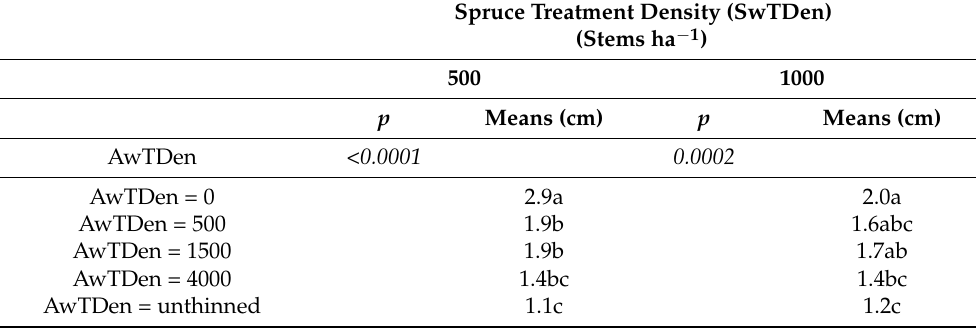
Table 6. Effects of treatments on maximum branch diameter in the branch whorl closest to 1 m of dominant spruce. Analysis for treatment effects was based on a factorial design with three levels for aspen density and two levels for spruce density—since the interaction term was significant, results were analyzed separately for each of the two spruce densities. For aspen treatment density (AwTDen), means followed by different letters (within each spruce density, SWTDen) differed significantly ( α = 0.05) based on Tukey’s HSD